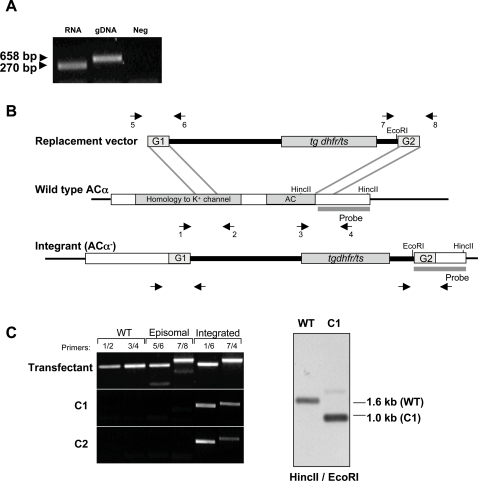
Generation of PbACα- parasite lines.(A) RNA from WT P. berghei sporozoites was reverse transcribed into cDNA and used as template to amplify ACα. Water was used as negative control (Neg) and wild type P. berghei genomic DNA (gDNA) as positive control. (B) Schematic representation of the ACα locus and the replacement vector. Correct integration of the construct results in the disrupted ACα gene as shown. Arrows indicate the position of the primers used for PCR in C. (C) Disruption of ACα was shown by PCR (left) and by Southern analysis (right). PCR on DNA of WT transfected population (before cloning) and PbACα- clones (C1 and C2) results in the amplification of two 0.7-kb WT fragments and a 0.8 and a 0.9-kb disrupted fragments when using the primers indicated in (B). Genomic Southern blot hybridization of WT and the PbACα- C1. The probe used for hybridization is represented in B. Integration of the targeting plasmid causes reduction in size of a 1.6-kb fragment in WT parasites to a 1.0-kb fragment in the PbACα- parasites. Similar results were found for PbACα- C2.